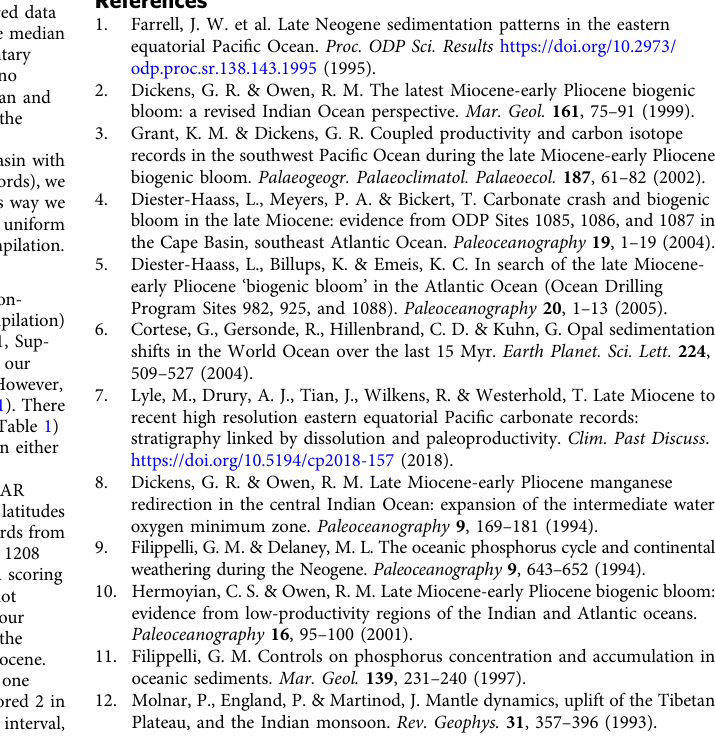
Fig. 3 Synthesis of orbital con fi guration, marine PP and chemical weathering intensity for the late Miocene to early Pliocene. a From top to bottom: Laskar 2011 53 eccentricity solution; Laskar 2004 74 obliquity solution. HOZ = High Obliquity Zanclean and LOZ = Low Obliquity Zanclean; Number of days with irradiance ≥ 350 W/m 2 at 20 °N; difference between summer and winter solstice irradiance (seasonality of insolation) at 20 °N. b Median standardized marine PP compilation, dashed lines indicate 15.9 and 84.1 percentiles (i.e. the central 68.2 percentiles) of the binned data (see Fig. 2d). c South China Sea records of the Rb/Sr ratio and the CIA index (100 × Al 2 O 3 /Al 2 O 3 + CaO + Na 2 O + K 2 O) at ODP Site 1146. Both proxies are used to describe variations in EASM and chemical weathering intensity 44 . Coloured horizontal bars indicate: (1) Period of intensi fi ed EEP upwelling 19 , (2) Period of North Paci fi c upwelling intensi fi cation 20 . (3,4) Main phases of Central American Seaway (CAS) shoaling and Gulf Stream (GS) intensi fi cation 22,29 . Vertical green shadings highlight the early Pliocene PP decline (4.6 – 4.4 Ma) and sustained lower PP in its aftermath as identi fi ed in this study. Source data for this fi gure are provided as a Source Data fi le.